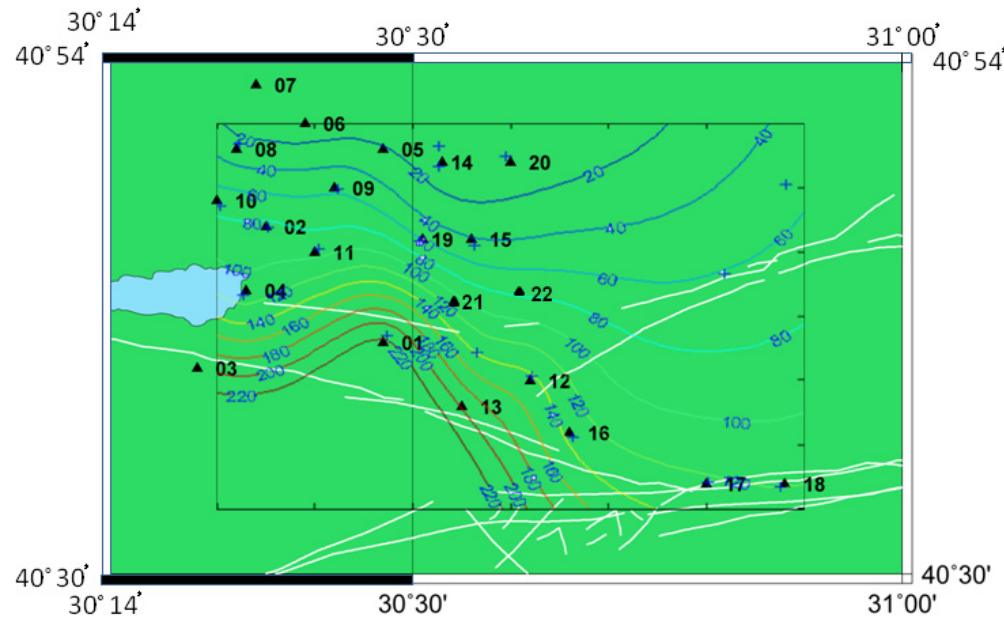
Fig. 6. Displacement field model. Absolute values of deformations are applied for modelling. Contours obtained by extrapolation are removed. Units of deformations are in metres.